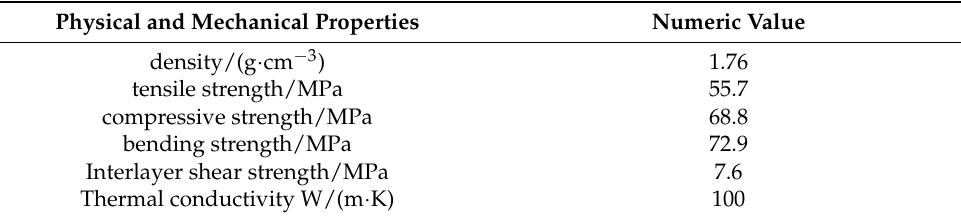
Table 1. Basic physical and mechanical properties of carbon/carbon friction sheet